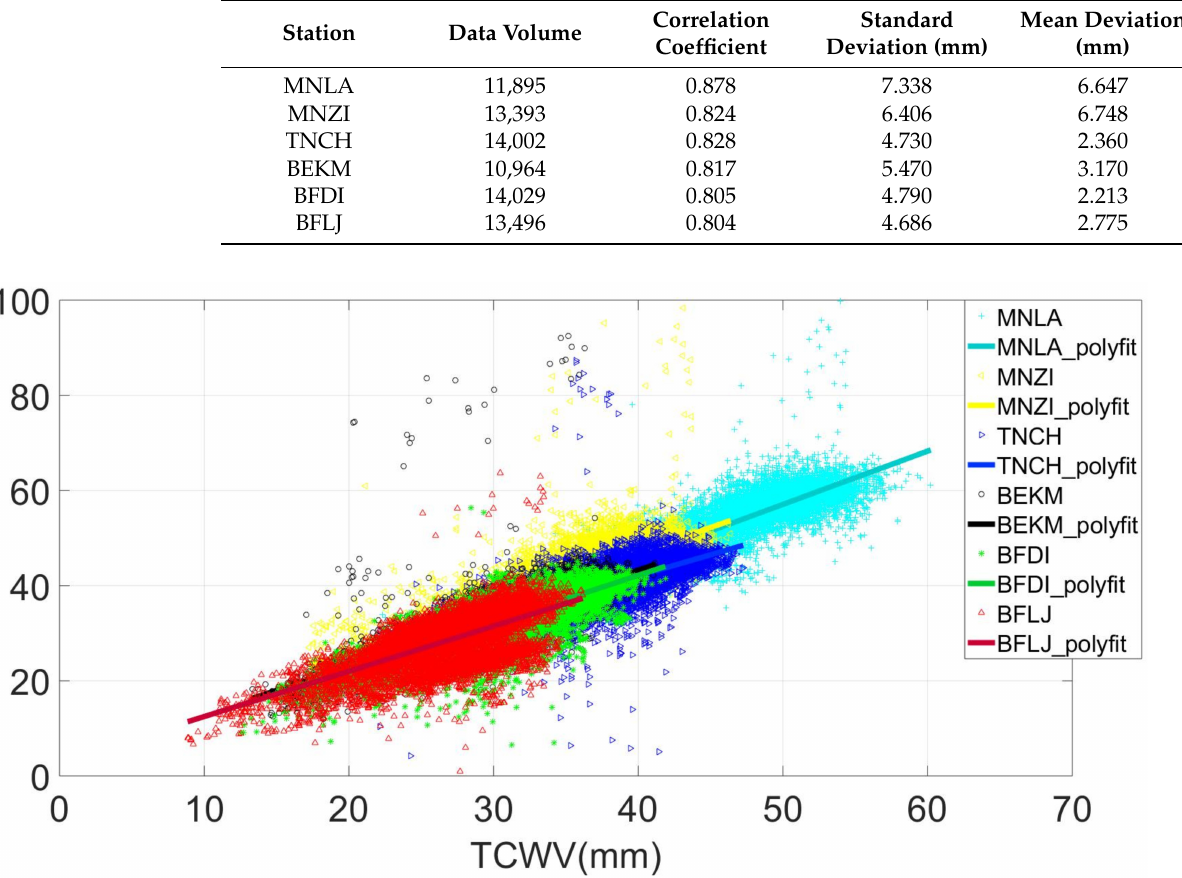
Figure 3. Scattered distributions and linear fitting results of TCWV and PWV of 6 stations (color scatter: scatter distribution of two kinds of data at each station; colored straight line: linear fitting of PWV (cyan: MNLA; yellow: MNZI; blue: TNCH; black: BEKM; green: BFDI; red: